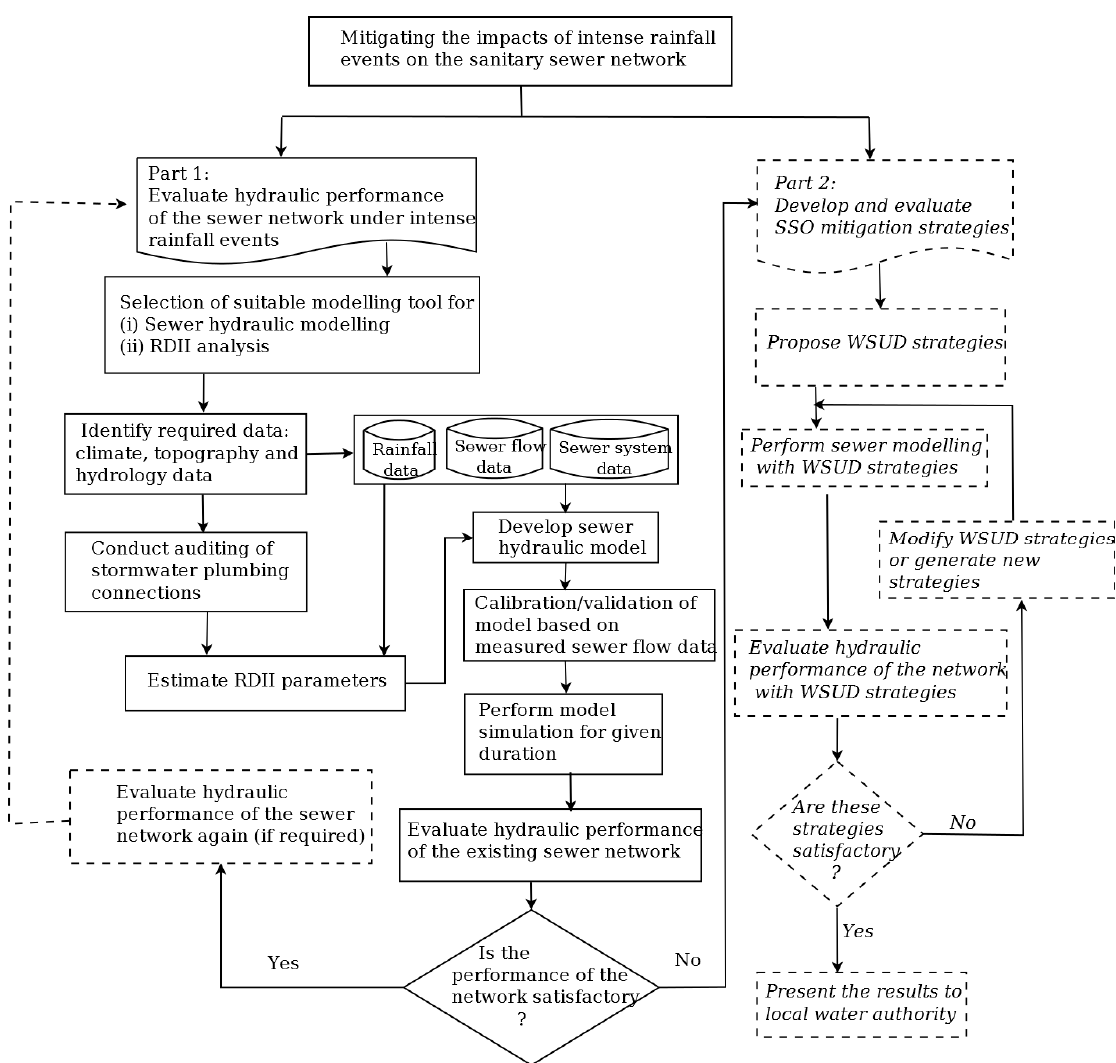
Figure 1. Generalised framework for assessing and mitigating the impacts of intense rainfall on the sanitary sewer network.